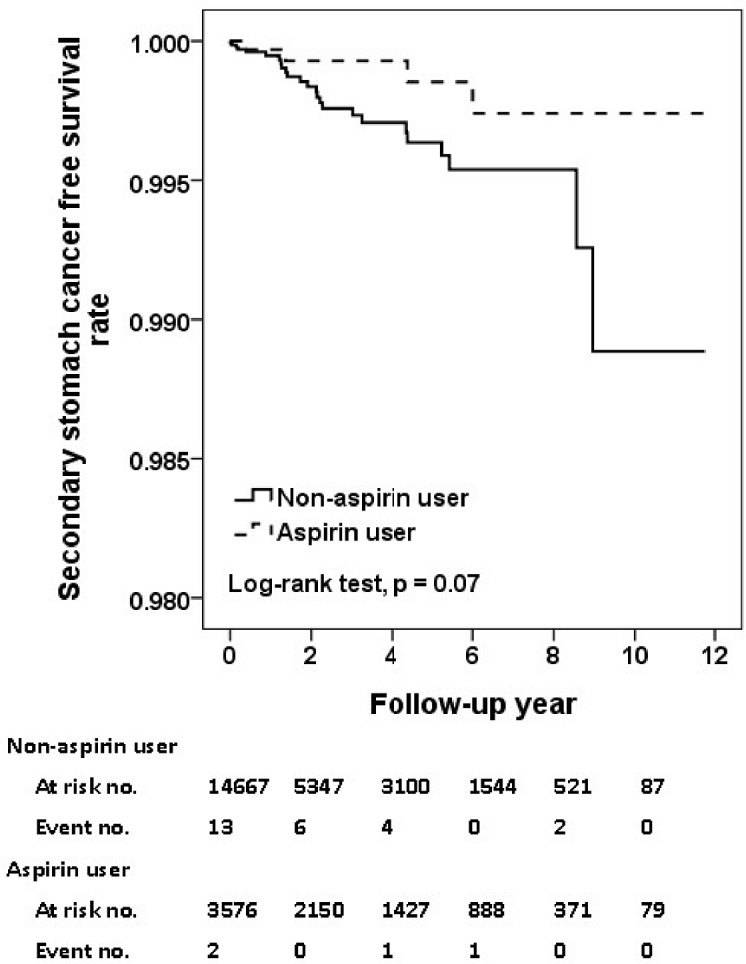
Secondary stomach cancer free survival rates for primary HNSCC cohort with and without aspirin intake.